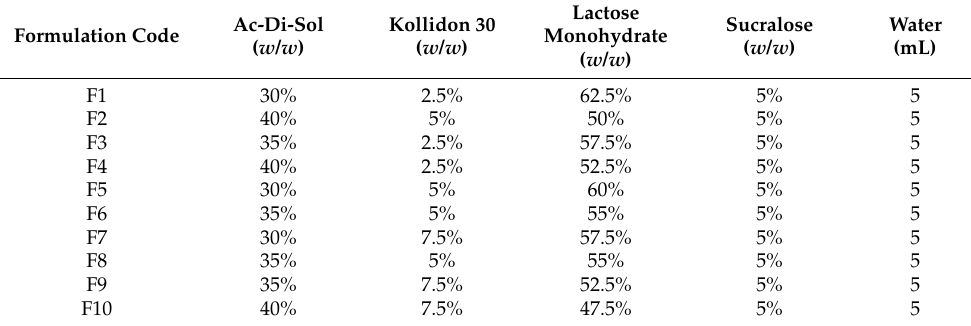
Table 3. Formula of each batch of CBZ